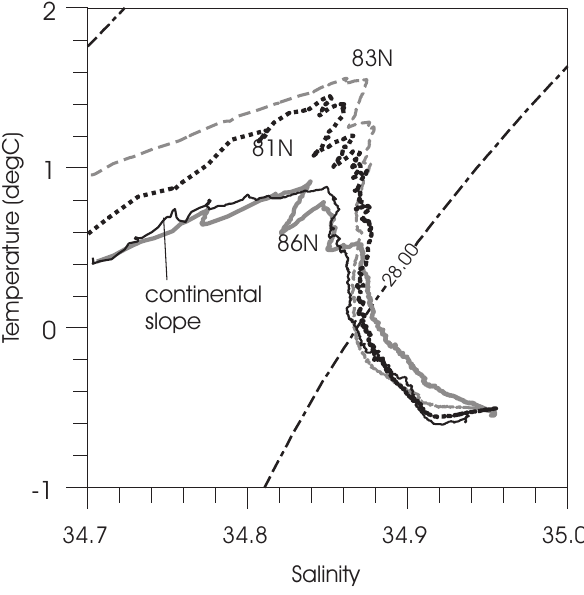
Fig. 11. Potential temperature vs. salinity in the Makarov Basin at different